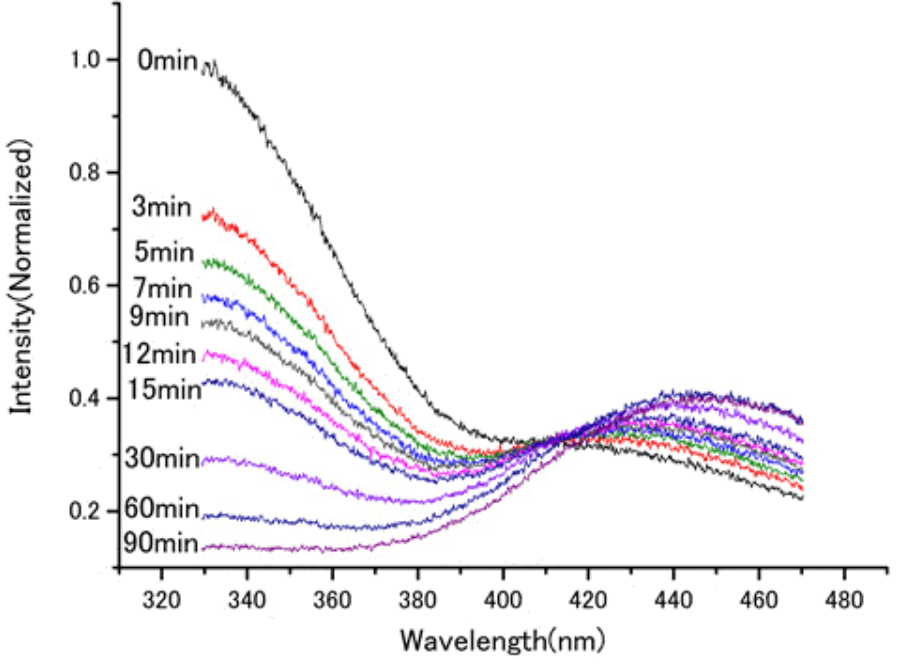
FIGURE 3. Time variation of fluorescence spectra of fingerprints. These spectra were measured with a 10-nsec delay